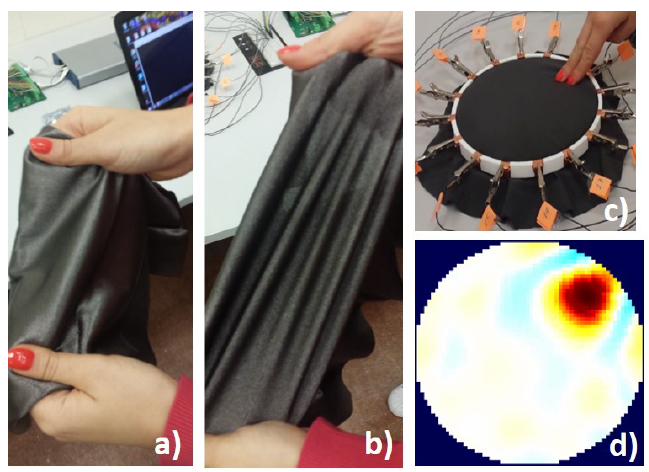
Figure 4. Our EIT-based stretchable sensor. In ( a ), the conductive fabric material in shown; and, in ( b ), the material when stretched; in ( c ), a touch pressure is applied over the sensor and, in ( d ), an image showing the conductivity change is reconstructed from the boundary voltage data. Red colour indicates a positive changes in the conductivity.